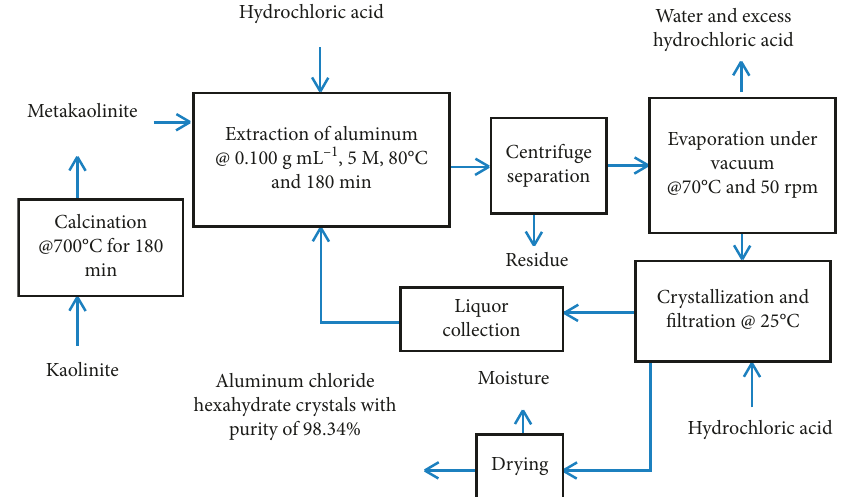
Figure 1: The process flow sheet of aluminum extraction from